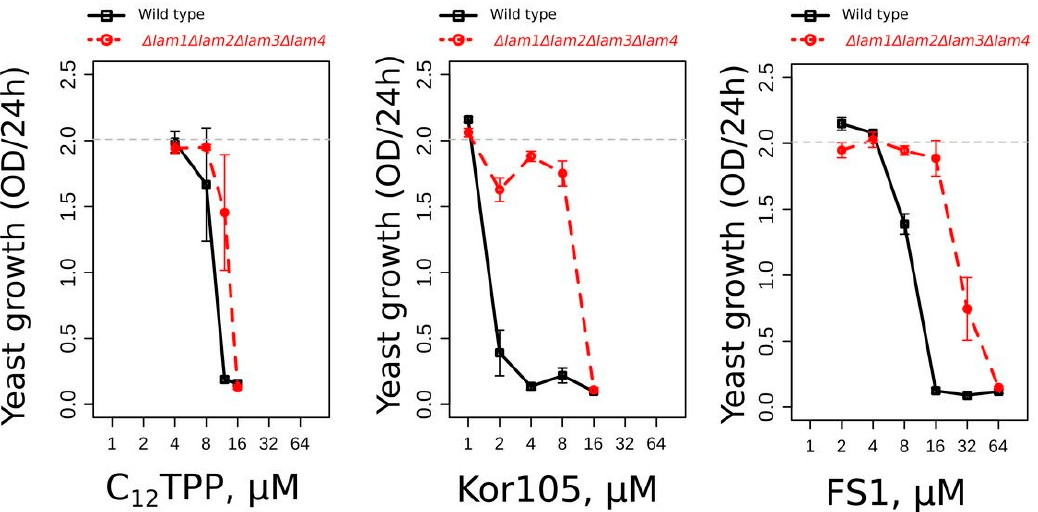
Figure 7. An increase in the plasma membrane (PM) ergosterol protects cells against the lipophilic cations. The graphs show the values of the cell densities grown for 24 h in the presence of the indicated concentrations of the cations. The wild-type and lam1-4-delta (the strain with elevated PM ergosterol) cells are compared on each graph. The cells were grown on YPD (YP-Dextrose) medium. Error bars correspond to standard deviations; n = 3.